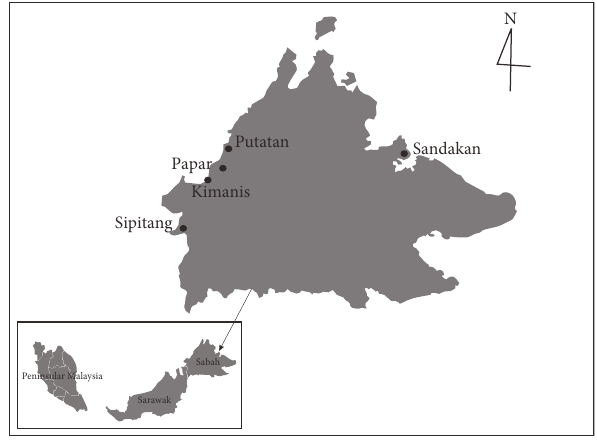
Figure 1: Localities of honey sampling in the State of Sabah,